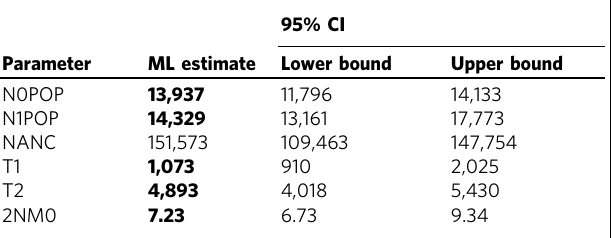
Table 1 Demographic parameters inferred under the best fi tting demographic model